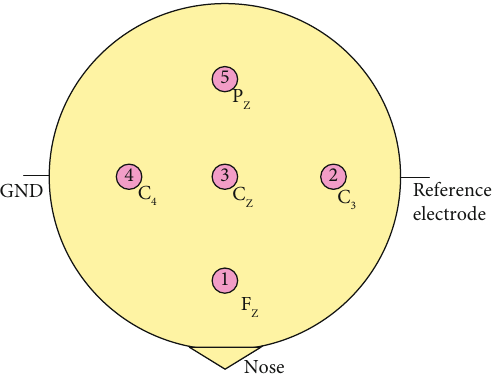
Figure 8: Position-based impedance control.